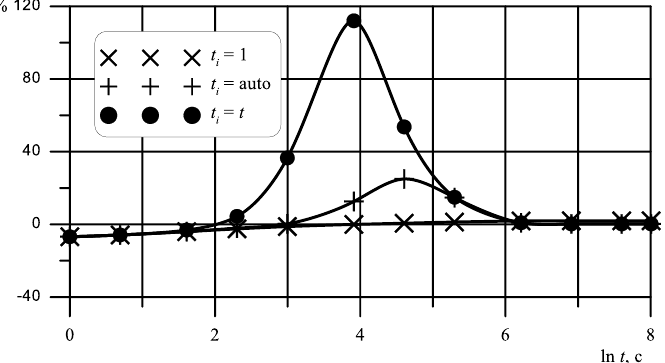
Fig. 5. The errors of solutions to the bending problem obtained by different methods with respect to the analytical method for different integration